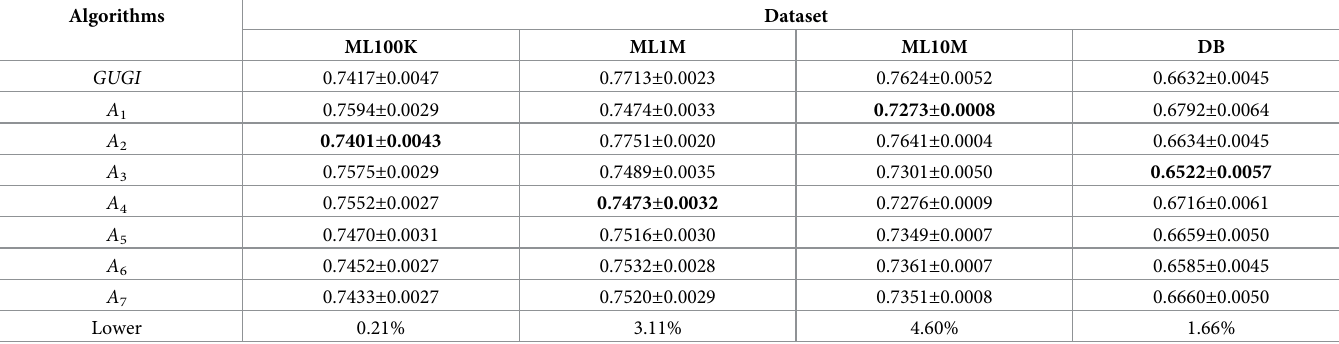
Table 5. MAE comparison under M-distance clustering.